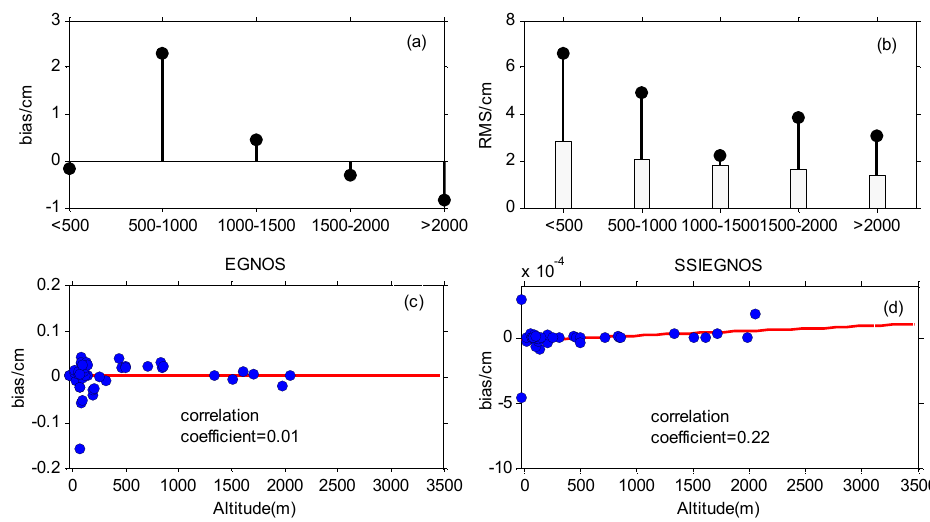
Figure 6. ( a , b ) show the annual bias and RMS error in each altitude range, respectively; ( c , d ) denote the correlations between altitude and bias and RMS error, respectively. Black stems and white bars represent the mean bias and RMS error of the EGNOS and SSIEGNOS models, respectively.